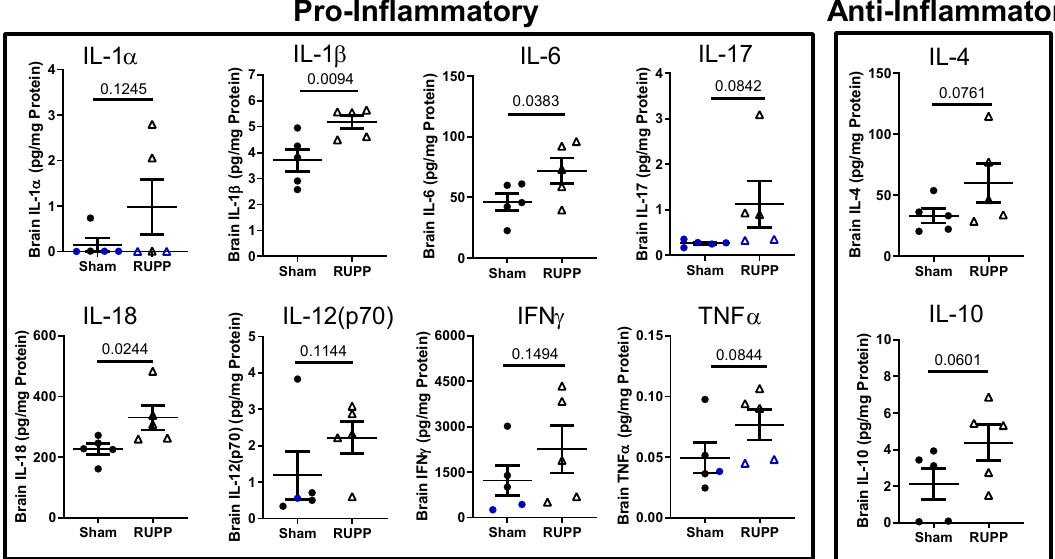
Figure 3. Placental ischemia leads to a shift towards a pro-inflammatory status in brains of exposed fetuses. A rat multiplex kit array of 27 cytokine / chemokine was used. Values were normalized to protein concentration. IL-1 β , IL-6, and IL-18 increased significantly in fetal brains exposed to placental ischemia. Blue points represent extrapolated values (one value below the lowest detectable value and normalized to protein concentration). Not shown are: IL-2, IL-5, and IL-13. Values for individual rat fetuses ( n = 5 fetuses per group) are shown along with the mean ± SEM. Only one fetal brain was collected per dam for cytokines/chemokines. There was a trend toward increased anti-inflammatory cytokines, IL-4 and IL-10. Lastly, the chemokines/growth factors eotaxin (CCL11), LIX/CXCL5, and MIP-2/CXCL2 increased significantly in fetal brains exposed to placental ischemia compared to sham-exposed (Figure 4).